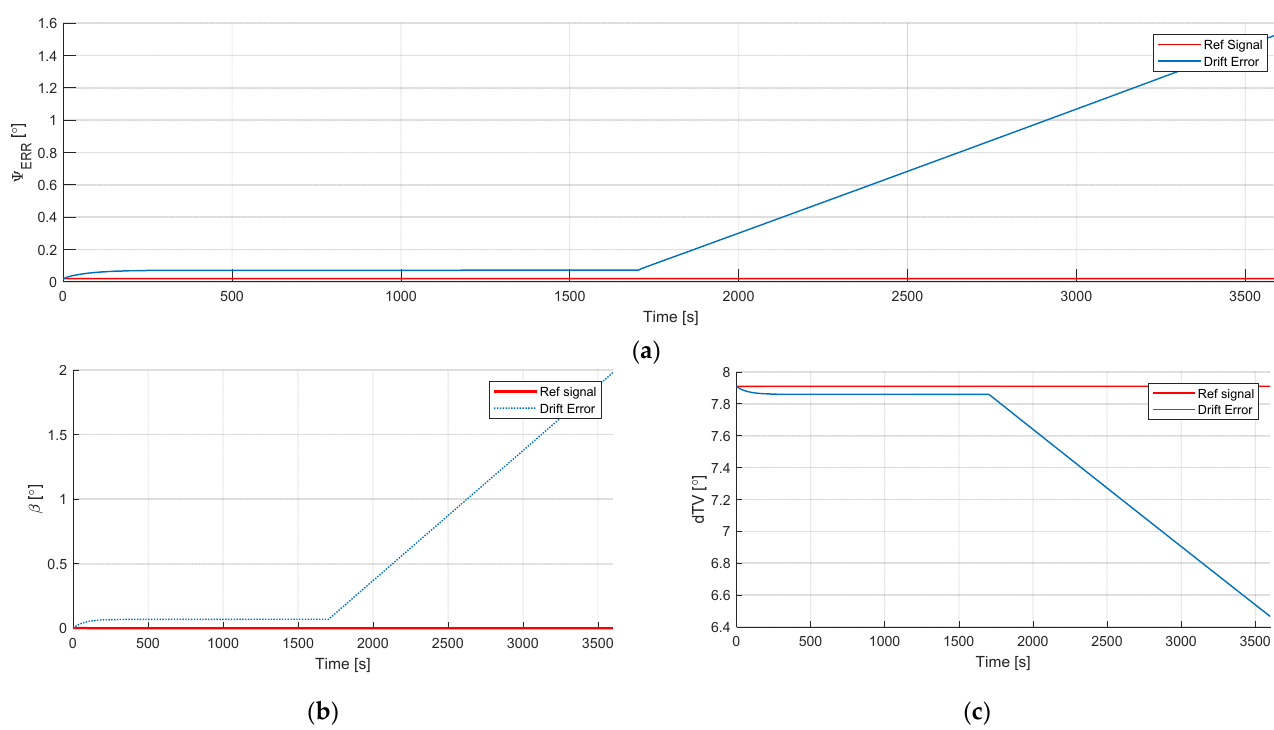
Figure 11. Influence of bias error of gyroscopes on a stable flight: ( a ) Comparison of altitude error; ( b ) Comparison of pitch angle error; ( c ) Comparison of elevator trimmer deflection.